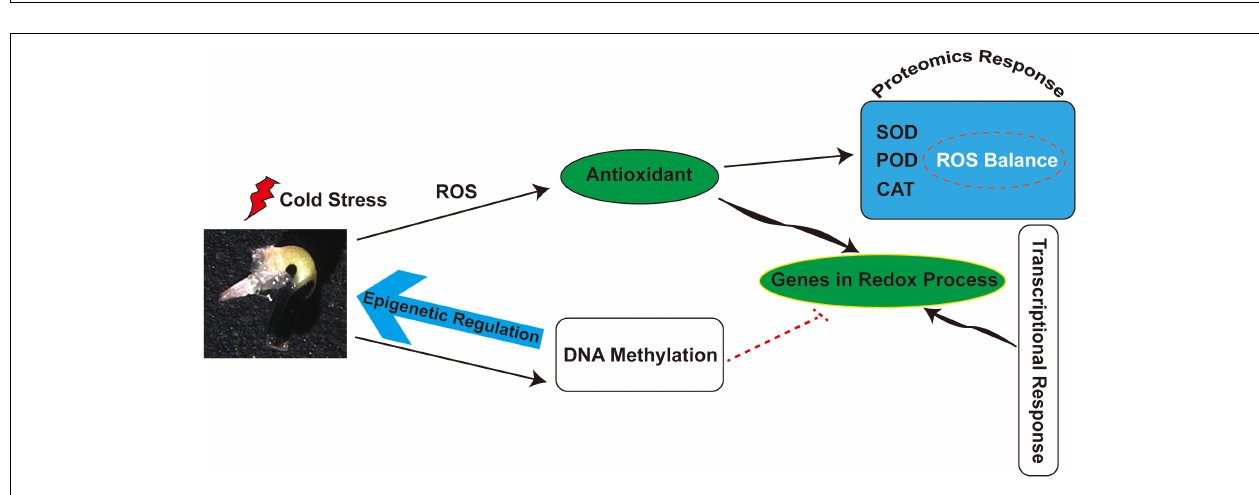
FIGURE 9 | A schematic overview of the physiological and epigenetic response to cold stress during the seed germination of M.